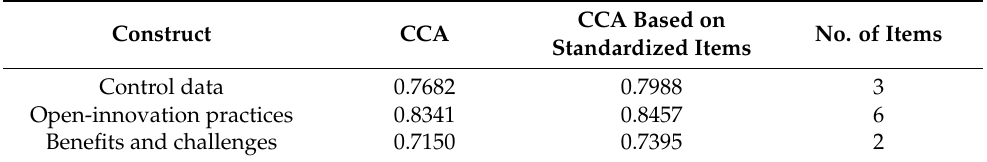
Table 3. Internal consistency of the questionnaire.